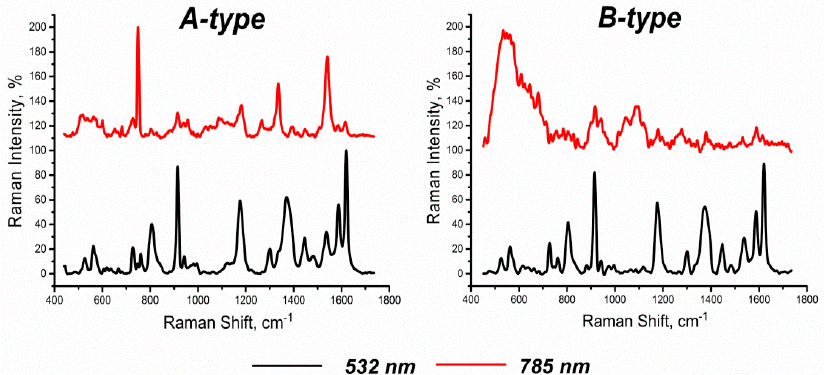
Figure 5. Raman spectra of A-type ink ( left ) and B-type ink ( right ). These Raman spectra were recorded using two laser excitation wavelengths: 785 nm and 532 nm.